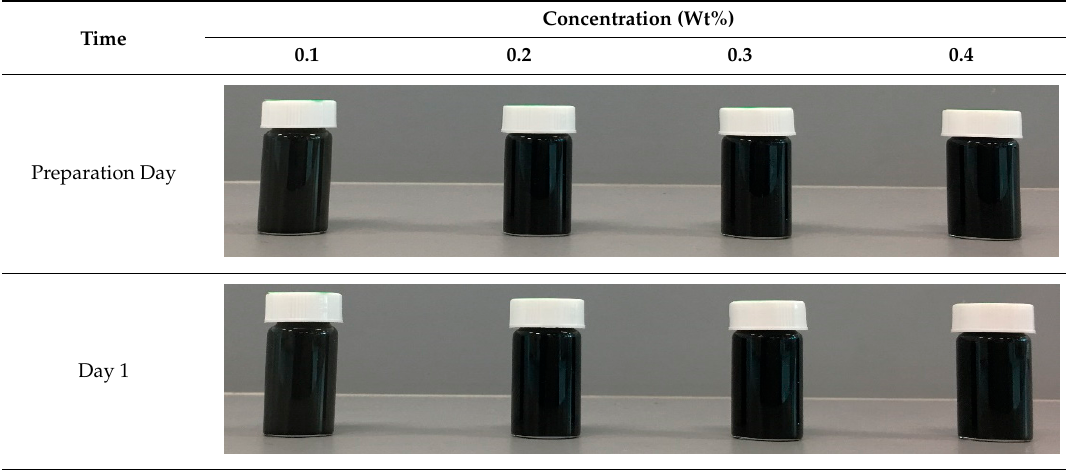
Figure 13. Electrical double-layer formation around the MXene nanoparticle.